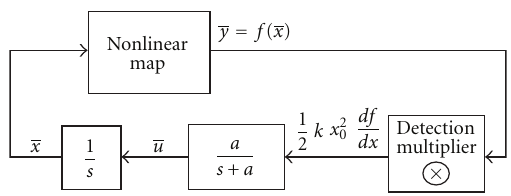
Figure 3: Averaged-signal extremum-seeking block